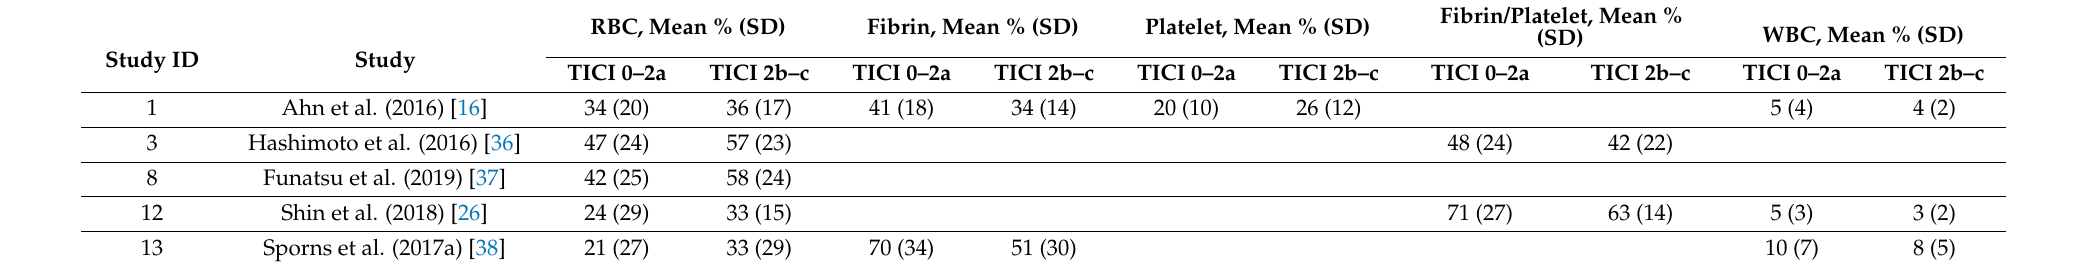
Table 3. Clot Component Fractions and TICI Score.